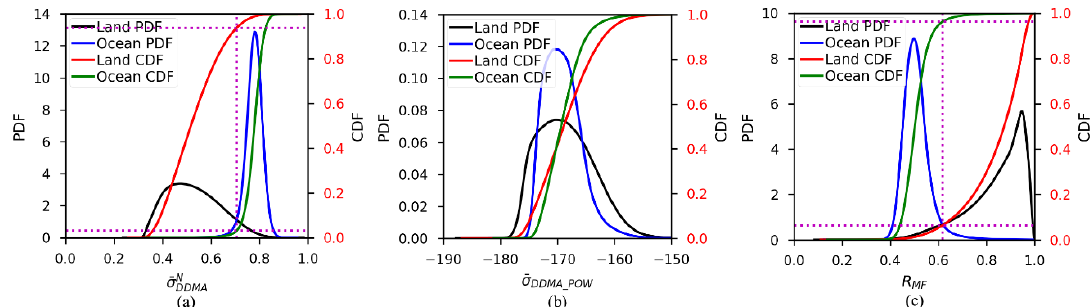
Figure 5. Average of the normalized scattering power DDM near its peak (DDMA) ( a ), an average of the absolute scattering power DDM near the peak (DDMA_POW) ( b ), and WAF-matched filter (MF) ( c ) statistic performance over land and ocean area, dataset collected from the CYGNSS level-1B in January 2018.